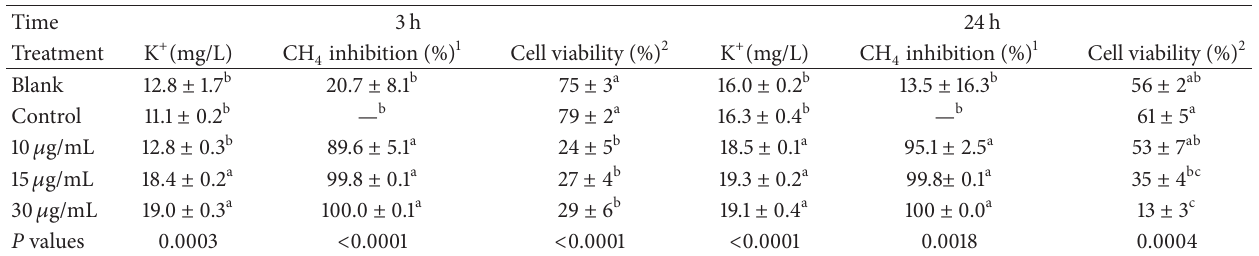
in different concentrations in Experiment 2 12